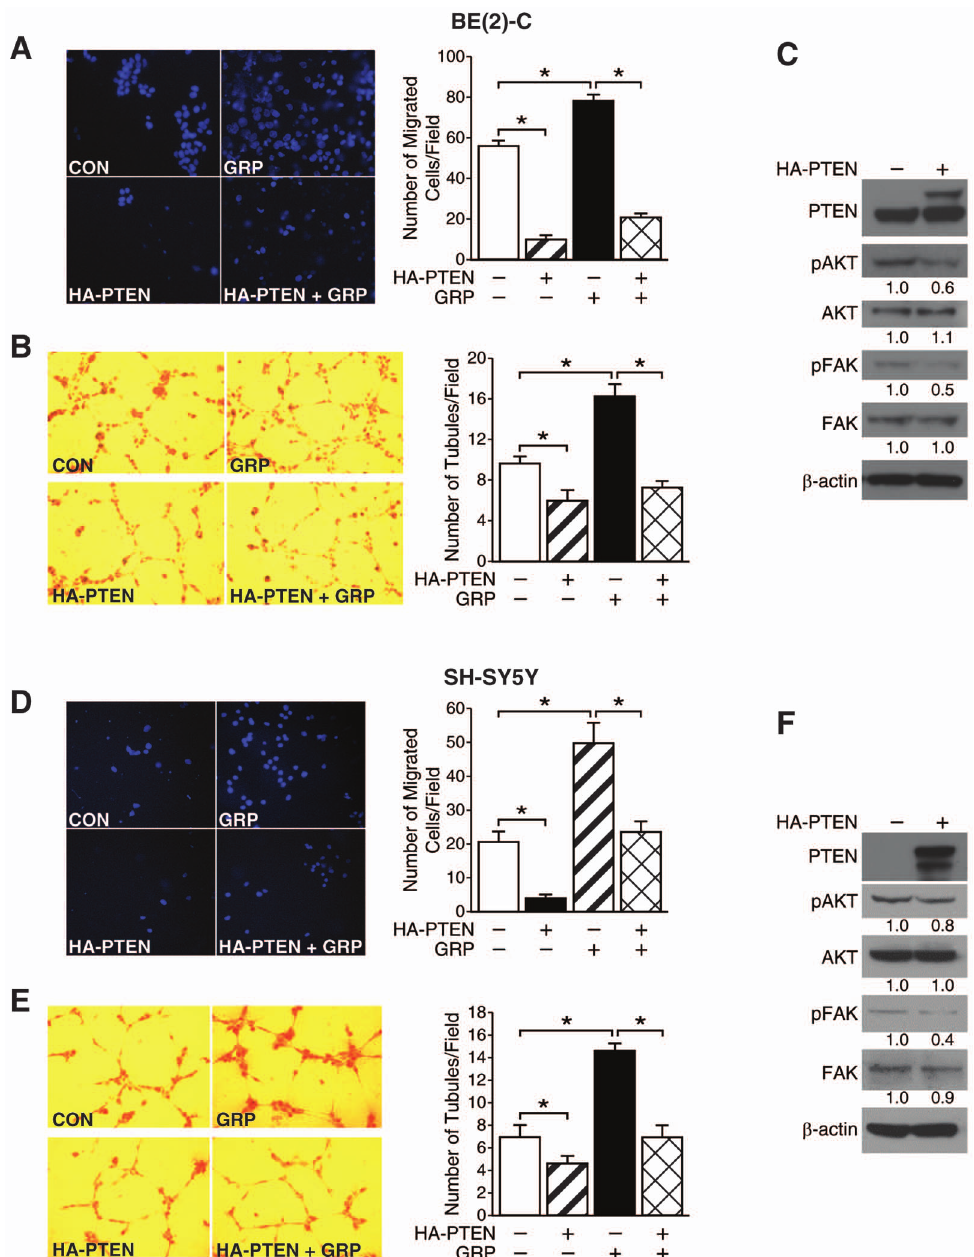
Figure 3. PTEN overexpression inhibited GRP-mediated neuroblastoma progression. (A, D) PTEN overexpression (HA-PTEN) decreased BE (2)-C and SH-SY5Y cell migration in comparison to vector control (CON) as assessed by transwell migration assay ( left panels ). GRP treatment increased BE (2)-C and SH-SY5Y cell migration ( top panels ); this was attenuated by PTEN overexpression (HA-PTEN + GRP) ( right panels ). (B, E) In vitro tubule formation by HUVECs grown in the supernatant of PTEN overexpressing BE (2)-C or SH-SY5Y cells (HA-PTEN) was markedly reduced in number in comparison vector control (CON) ( left panels ). GRP-mediated (GRP) increase in HUVEC tubule formation was inhibited when grown in supernatant from PTEN overexpressing BE (2)-C or SH-SY5Y cells (HA-PTEN + GRP) ( right panels ). (C, F) PTEN overexpression in BE (2)-C and SH-SY5Y cells decreased pAKT and pFAK as assessed by immunoblotting. b -actin was used as a loading control (mean 6 SEM; *= p , 0.05).